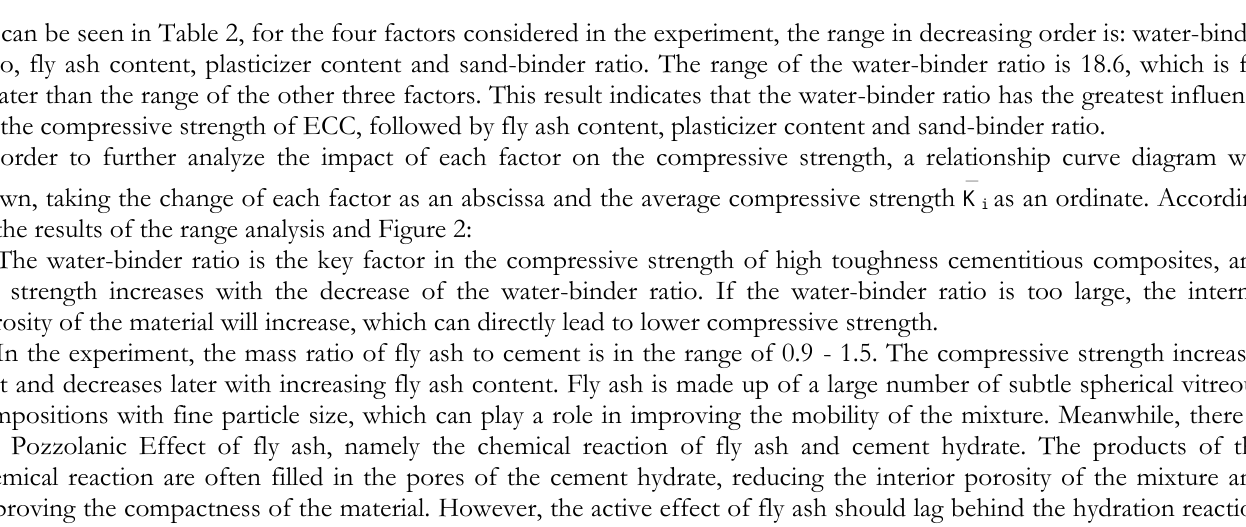
Table 2: Orthogonal experiment result of compressive